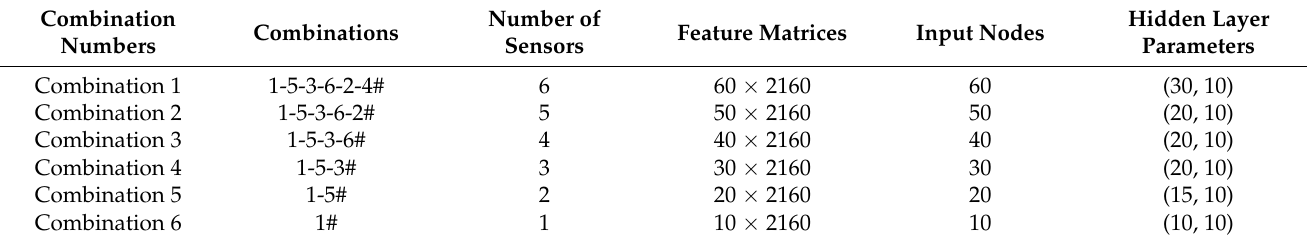
Table 7. The data sets with different sensor combinations.